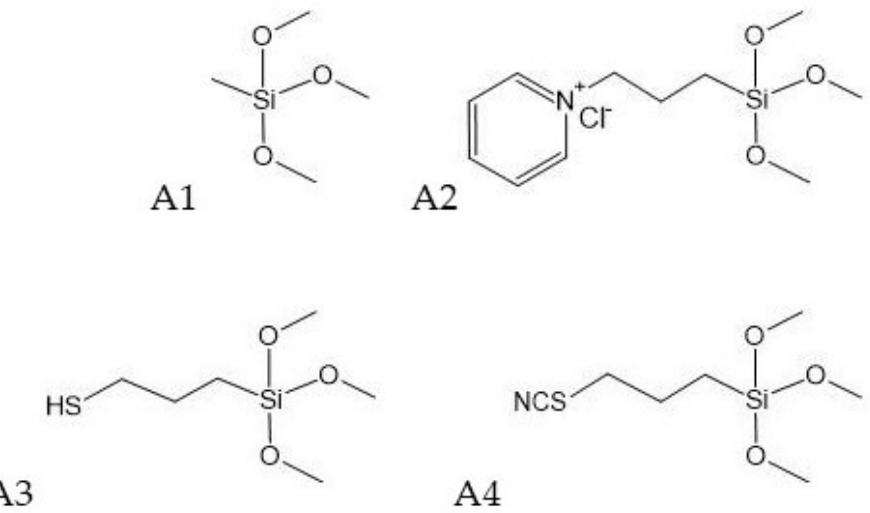
Figure 1. Chemical structures of alkoxysilanes used for waterlogged wood conservation.